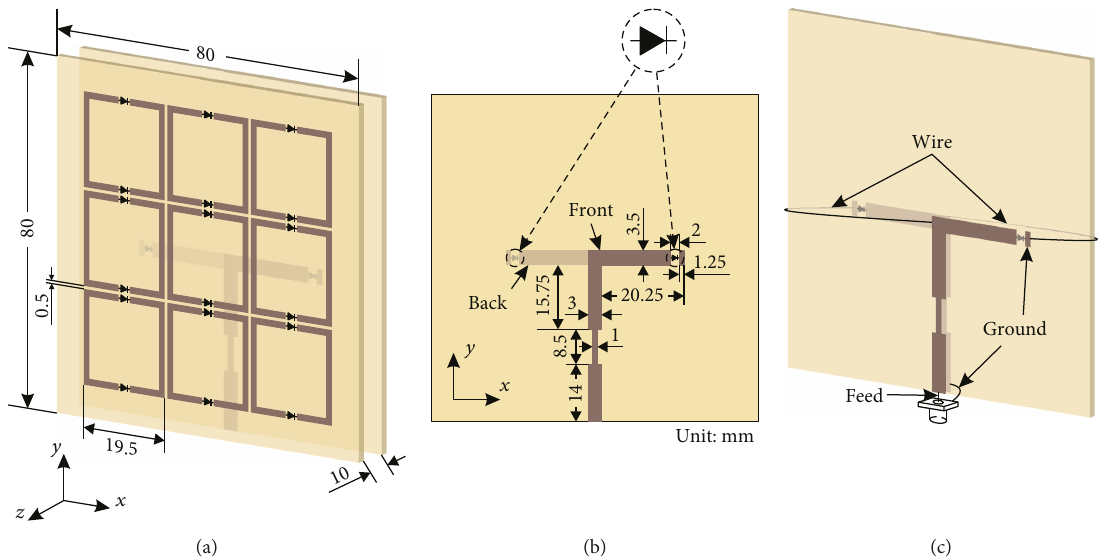
Figure 2: Structure of the proposed PIN diode-based recon fi gurable metasurface antenna for beam switching applications: (a) perspective view and (b) the dipole excitation source. (c) Diagram showing how PIN diodes are connected to two radiating arms of the